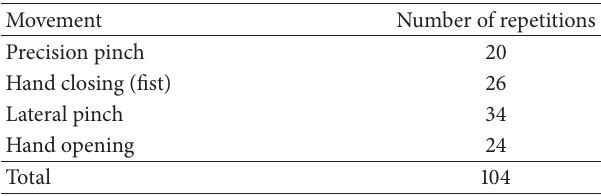
Table 1: Movements performed for BCI